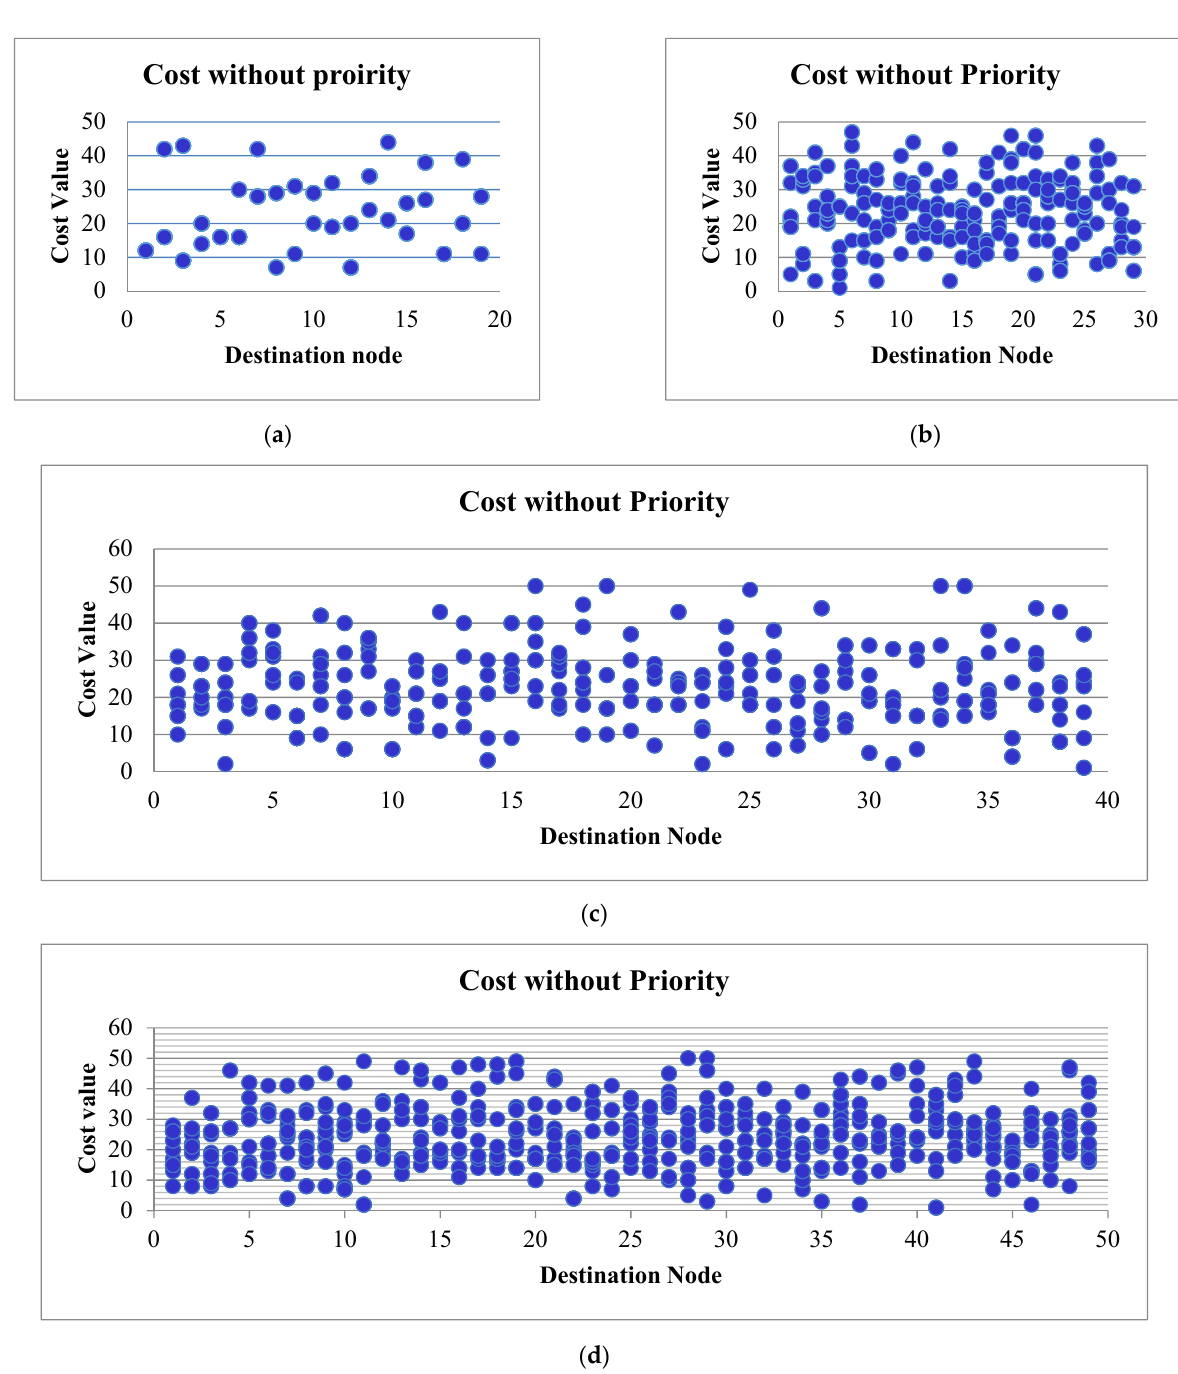
Figure 7. Available paths in the same networks. ( a ) Available paths with 20 nodes; ( b ) available paths with 30 nodes; ( c ) available paths with 40 nodes; ( d ) available paths with 50 nodes.